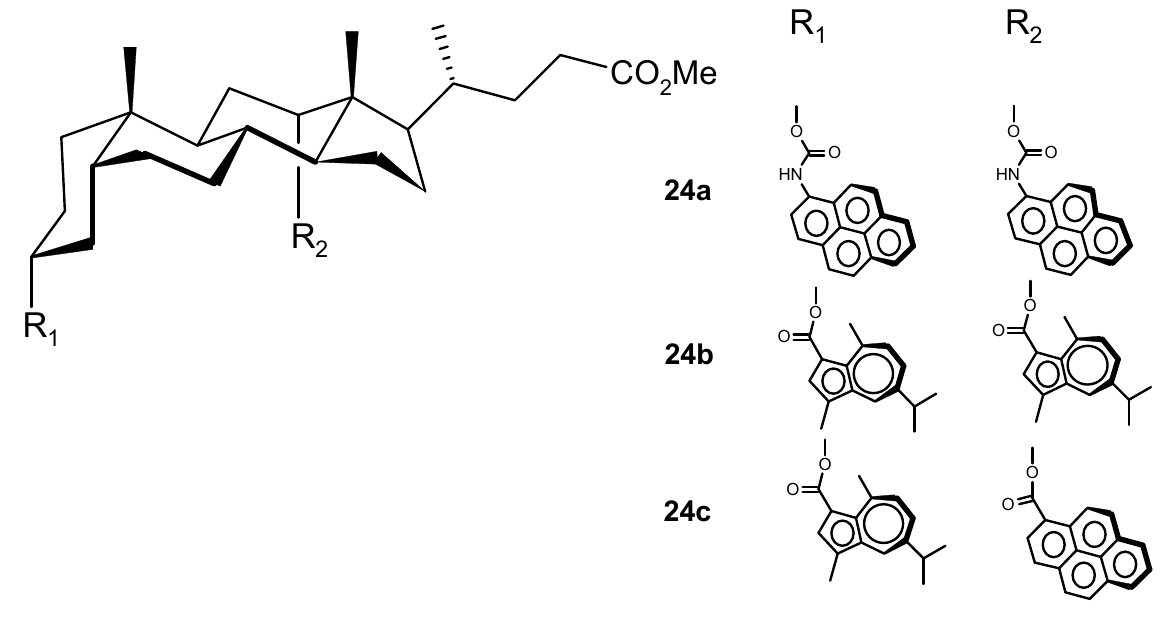
Figure 13. Novel bile acid-based molecular tweezers